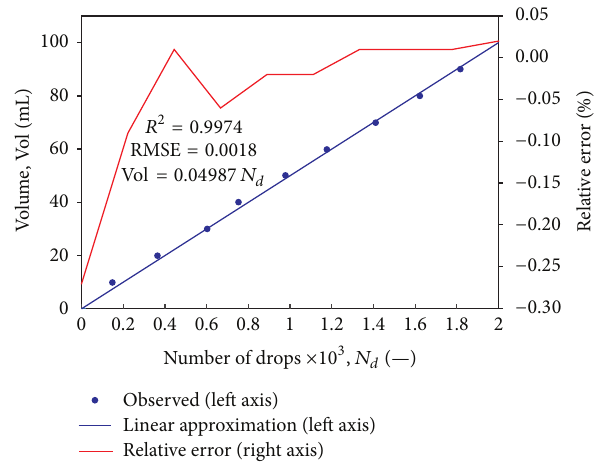
Figure 4: Calibration results of the drop counter expressed as vol- ume of water (left axis) added at the upper boundary versus number of drops, 𝑁 𝑑 , detected by the sensor. The linear approximation (left axis) and the relative error (right axis) are also